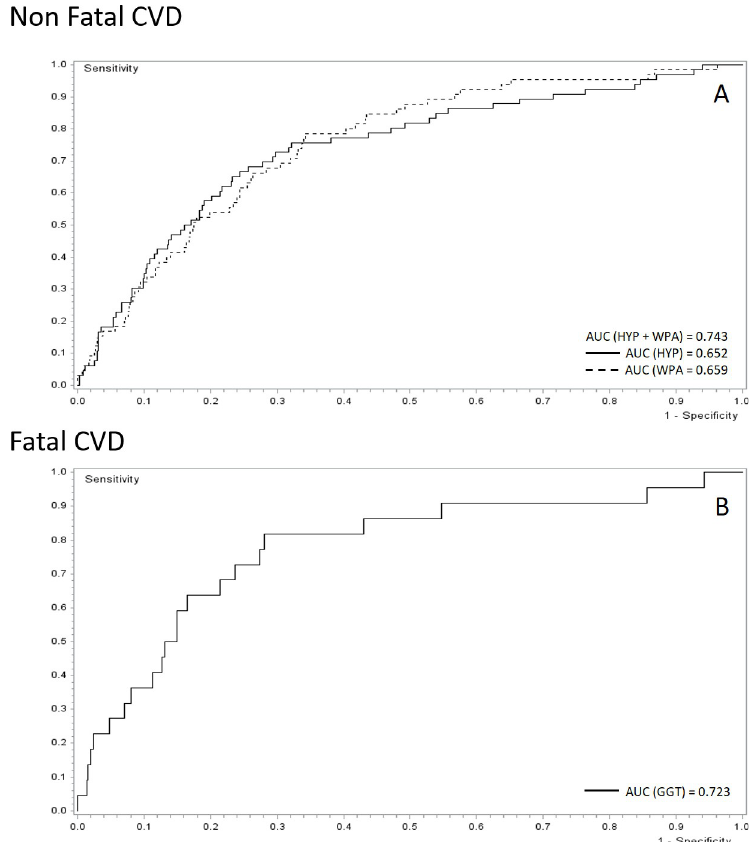
Fig 2. ROC curve of risk factors related to non-fatal and fatal CV outcomes. HYP: Hypertension, WPA: Weighted Physical Activity Index, GGT: Gamma-glutamyl-transferase.